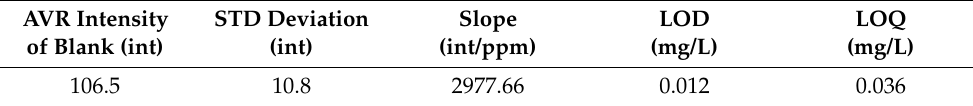
Table 2. Si determination by ICP-OES: limits of detection (LOD) and limits of quantification (LOQ).